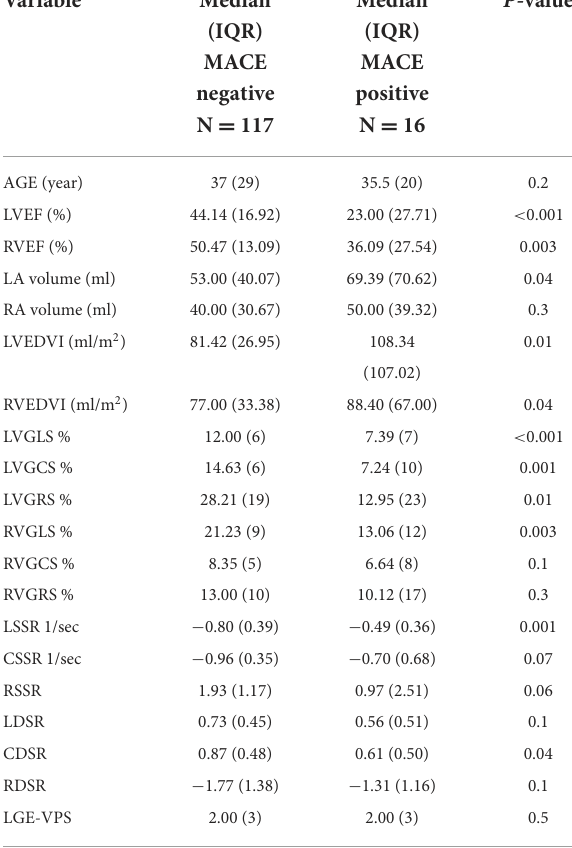
TABLE 3 Comparison of age and CMR parameters between MACE negative and positive